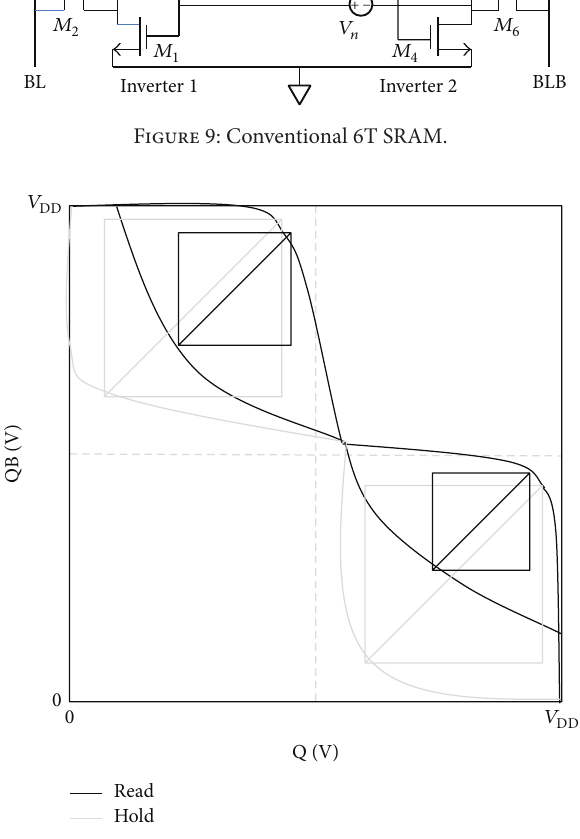
Figure 10: Read and hold SNMs [9].